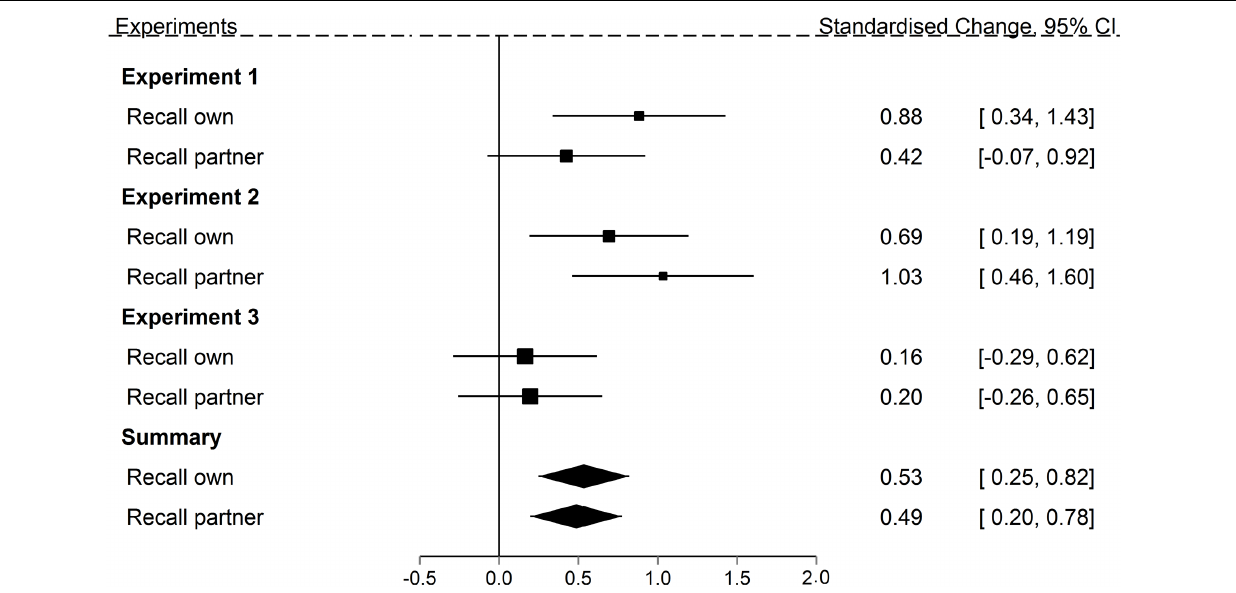
Frontiers in Psychology |